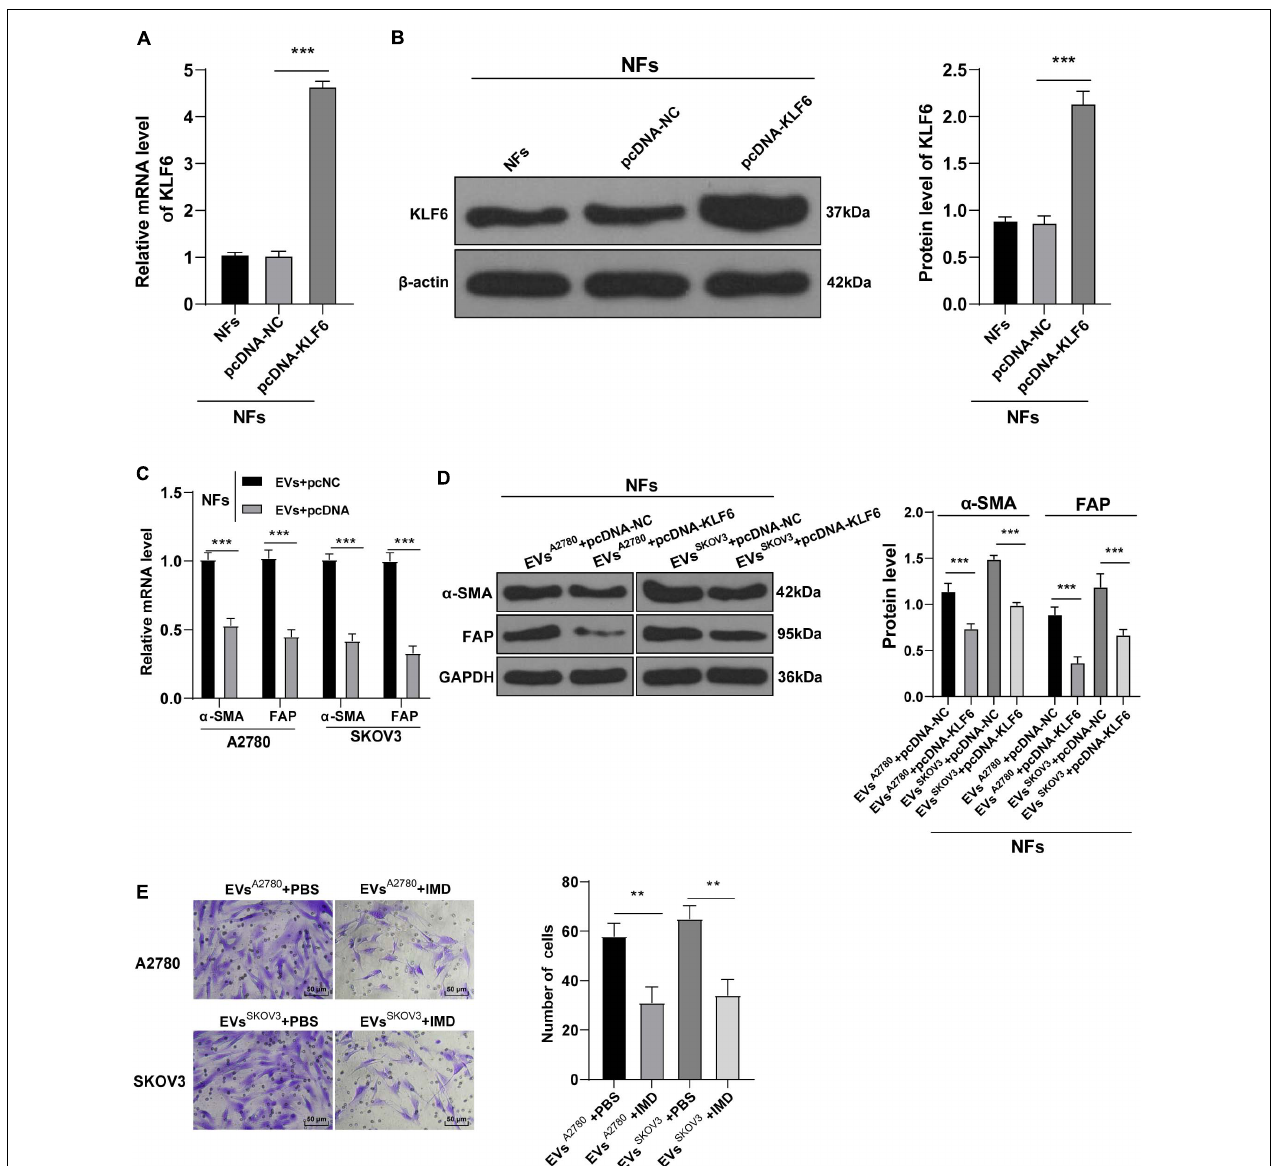
FIGURE 5 | Overexpression of KLF6 attenuated EVs-induced activation of CAFs. NFs were co-treated with A2780 or SKOV3 cells-derived EVs and KLF6 pcDNA or its NC. (A,B) Transfection efficiency of KLF6 pcDNA was confirmed using RT-qPCR and Western blotting; (C,D) levels of CAFs marker proteins ( α -SMA and FAP) in NFs were detected using RT-qPCR and Western blotting. (E) Migration of NFs in each group was detected using Transwell assay; the migrated cells were counted and representative images were displayed. The experiment was repeated three times independently. Data are presented as mean ± standard deviation and analyzed using one-way ANOVA, followed by Tukey’s multiple comparison test, ** p < 0.01, *** p < 0.001. A2780 and SKOV3 in the panels (C,D) indicated the source of